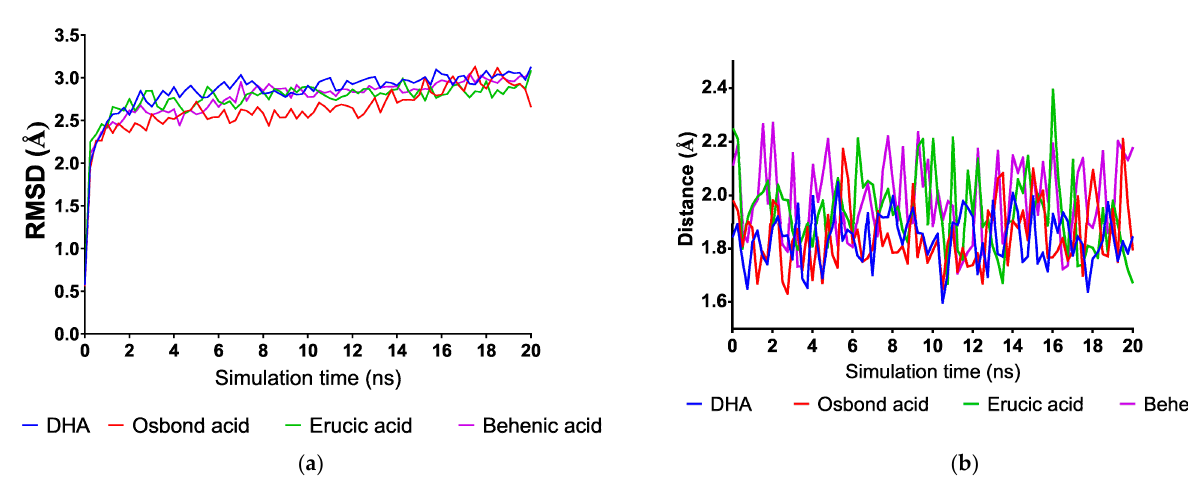
Figure 6. Variations along simulation time of ( a ) root mean square deviation (RMSD) and ( b ) distance from carboxylate groups of the fatty acid to Arg 408 in the adjacent subunit.